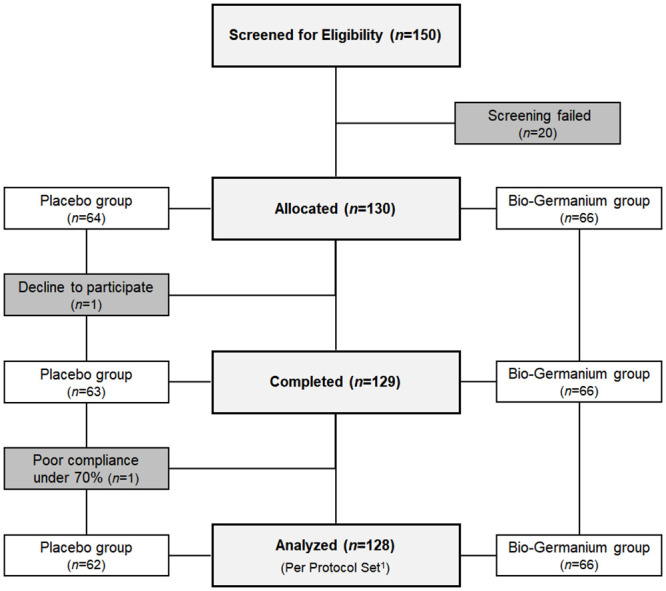
Flow diagram of subject randomization.1 Completed the clinical trial without major protocol violations.